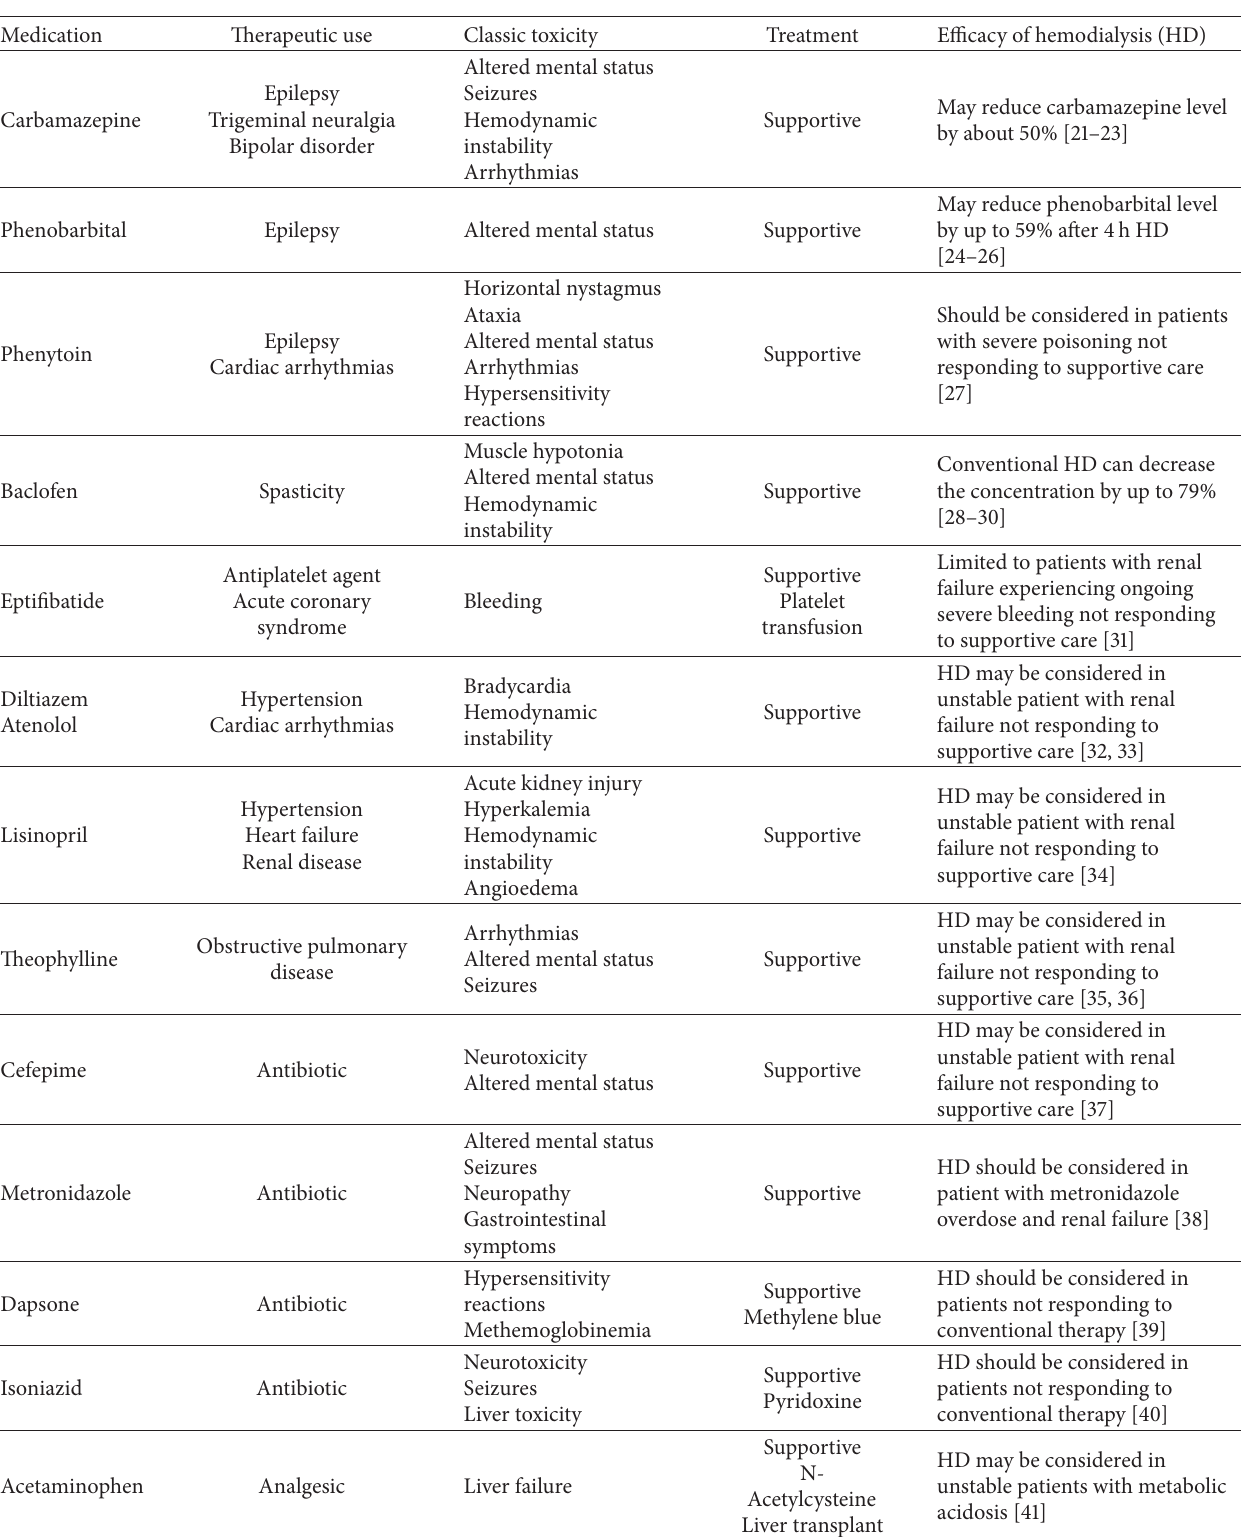
Table 4: Role of hemodialysis in the management of miscellaneous pharmacological